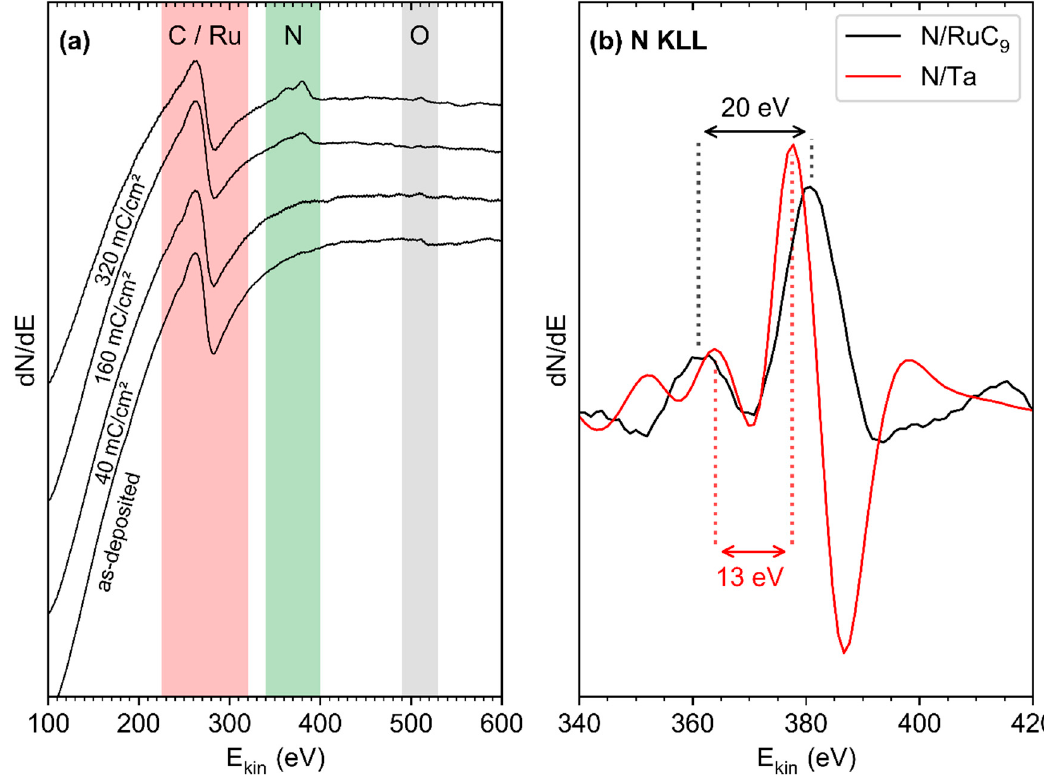
Figure 6. ( a ) Derivative Auger electron (AE) spectra collected for a model deposit fabricated by electron irradiation ( E 0 = 31 eV, 60 mC/cm 2 ) from 7 to 10 ML (EtCp) 2 Ru on a Ta substrate held at 110 K and subsequent annealing (450 K), in the as-deposited state and after different cycles of processing. Each cycle consisted of dosing of a multilayer NH 3 film (4 mTorr) onto the deposit held at 110 K, electron irradiation at 110 K ( E 0 = 31 eV, 40 mC/cm 2 ), and annealing (450 K). ( b ) Enlarged view of the N KLL region of the model deposit after 320 mC/cm 2 processing (black curve) and of the bare Ta substrate after exposure to the exact same 320 mC/cm 2 processing (red curve).